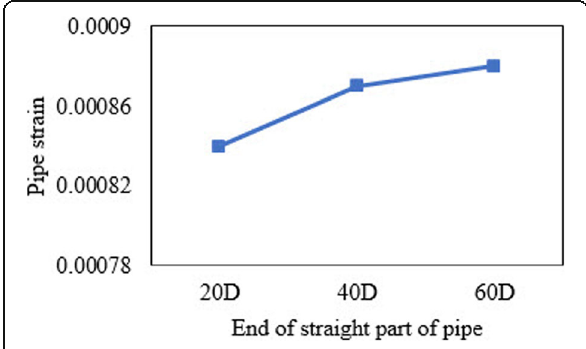
Fig. 4 Sensitivity of straight part vs. pipe strain at elbow in 3D models under Northridge earthquake record ( SF = 0.7; rock type R4; D/t = 99)